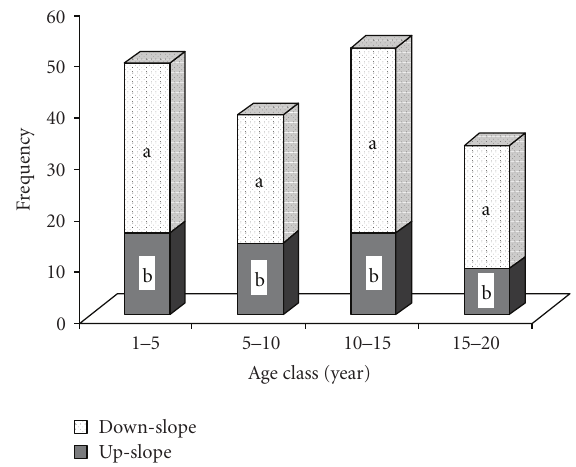
Figure 1: Number of damaged trees based on two directions of skid trail (up and downslops) in di ff erent tra ffi c intensity.